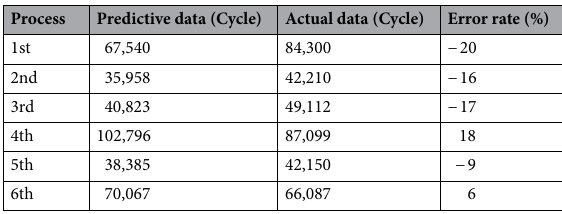
Table 5. Quantitative evaluation result of die life cycle.